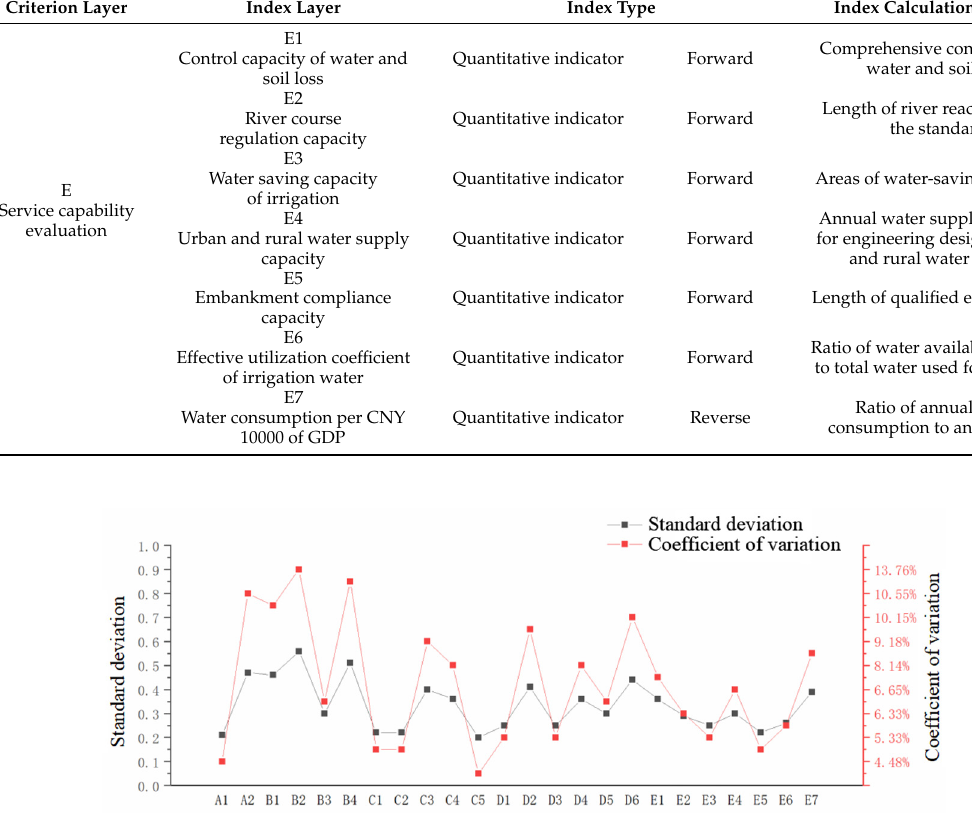
Figure 2. Standard deviation and coefficient of variations in index layer. Table 2. Result of statistical analysis of indicators at the index layer.